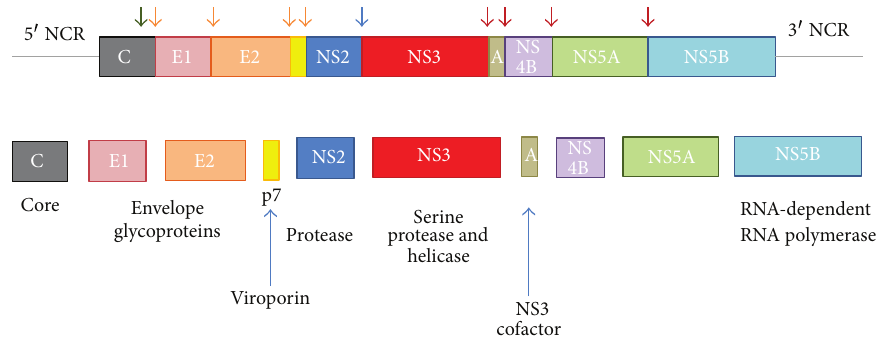
F 3: Genomic organisation of HCV showing the RNA, the polyprotein, and its products, following proteolytic cleavage. Cleavages by host signalases are shown in green and orange arrows, and those by virally encoded enzymes in blue (NS2/NS3) and brown